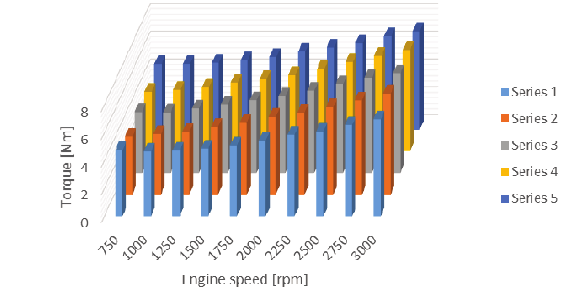
Fig. 6. Course of torque for the five series measuring – oil temperature 110°C